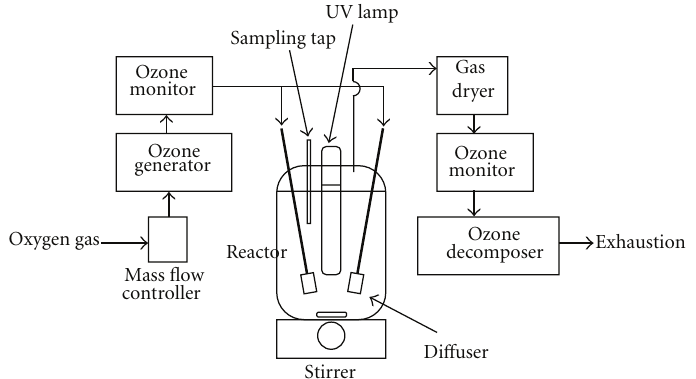
Figure 1: Experimental